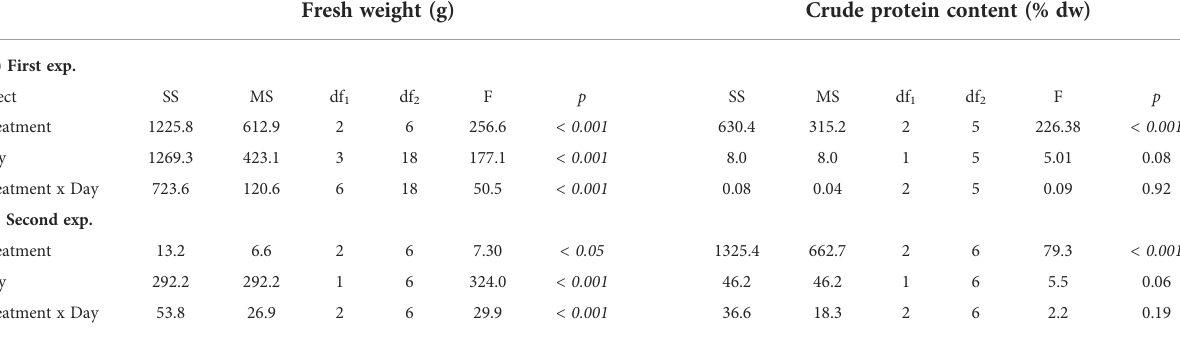
TABLE 2 Two-way mixed model ANOVA (Type III) of fresh weight (g) and crude protein content (% dw) in the (A) fi rst, and (B) second experiment of Ulva fenestrata cultivated in the two different herring production process waters (SAL and TUB), as well as the seawater control (SW).